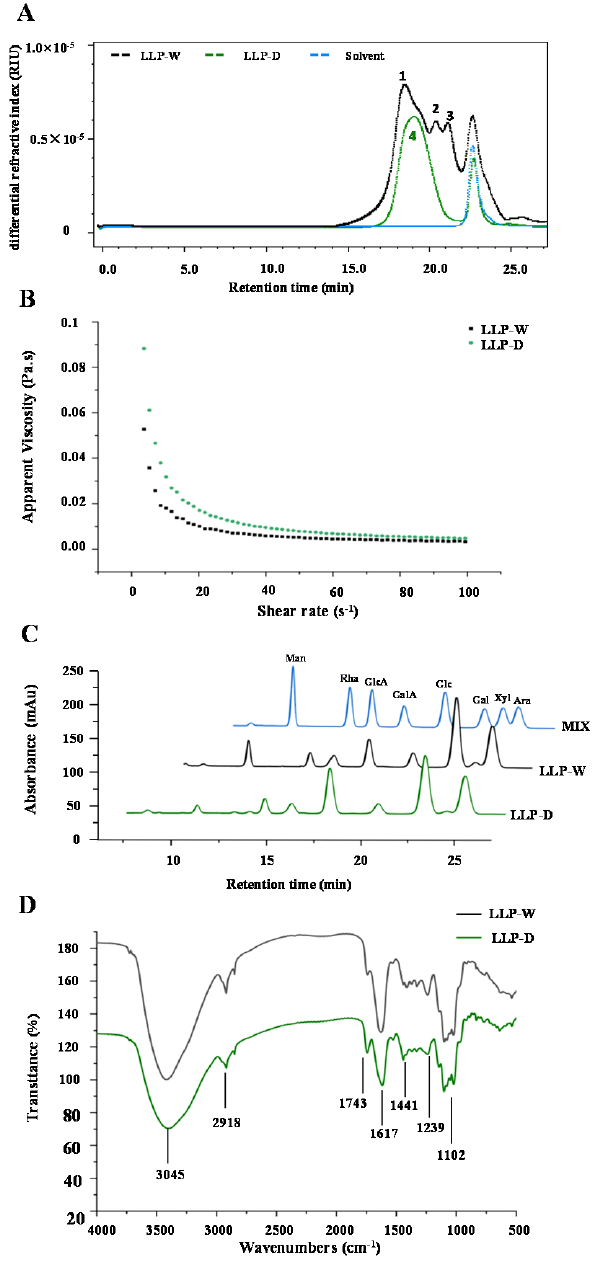
Figure 4. Size exclusion chromatograms ( A ), apparent viscosities on the shear rate ( B ), high perfor- mance liquid profiles of monosaccharides ( C ), and FT-IR spectra ( D ) of LLP-D and LLP-W. LLP-D and LLP-W are polysaccharides from lotus leaves extracted by deep eutectic solvent and hot water, respectively; Rha, rhamnose; GalA, galacturonic acid; Ara, arabinose; Gal, galactose; GlcA, glucuronic acid; Glc, glucose; Xyl, xylose.